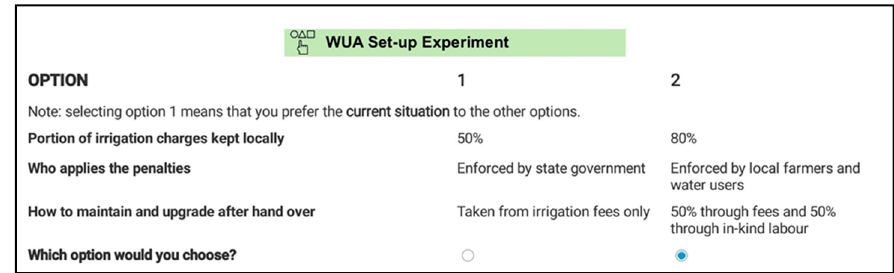
Figure 3. Example choice set: DCE 2.